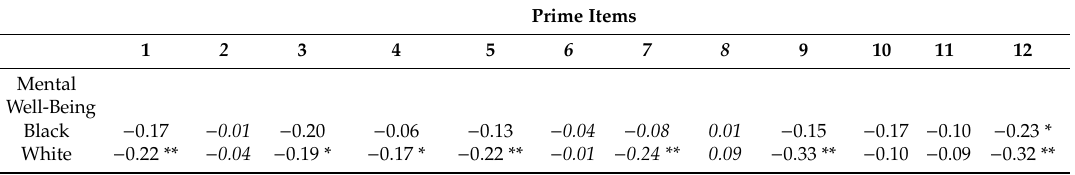
Table 4. Correlation coe ffi cients for Prime Screen items and Mental Well-Being Scores. Prime Items